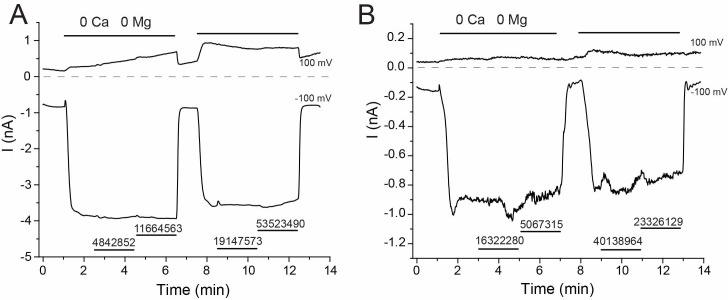
Representative traces for tested compounds that had no effect on rbTRPV5 activity.Compounds in (A) were tested at 10 μM, compounds in (B) were tested at 3 μM. Compounds are labeled with their ZINC ID. Experiments were performed and displayed as in Figure 1.